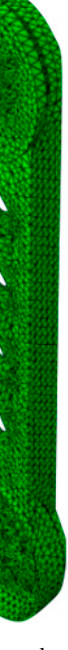
Figure 20. Modified topological structure.